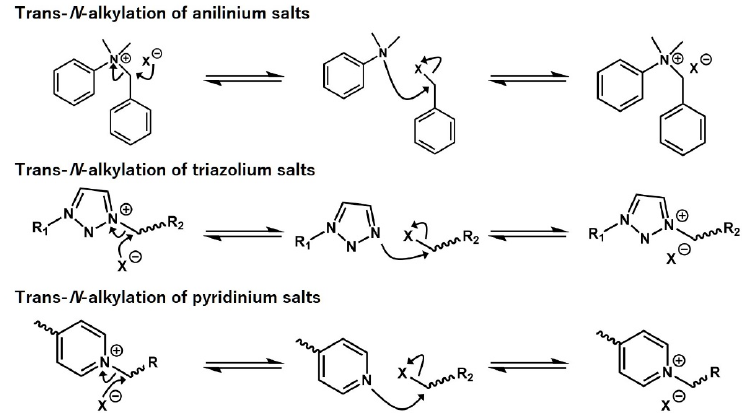
Figure 6. Reported examples of the trans- N -alkylation reaction of quaternized amino-based salts.